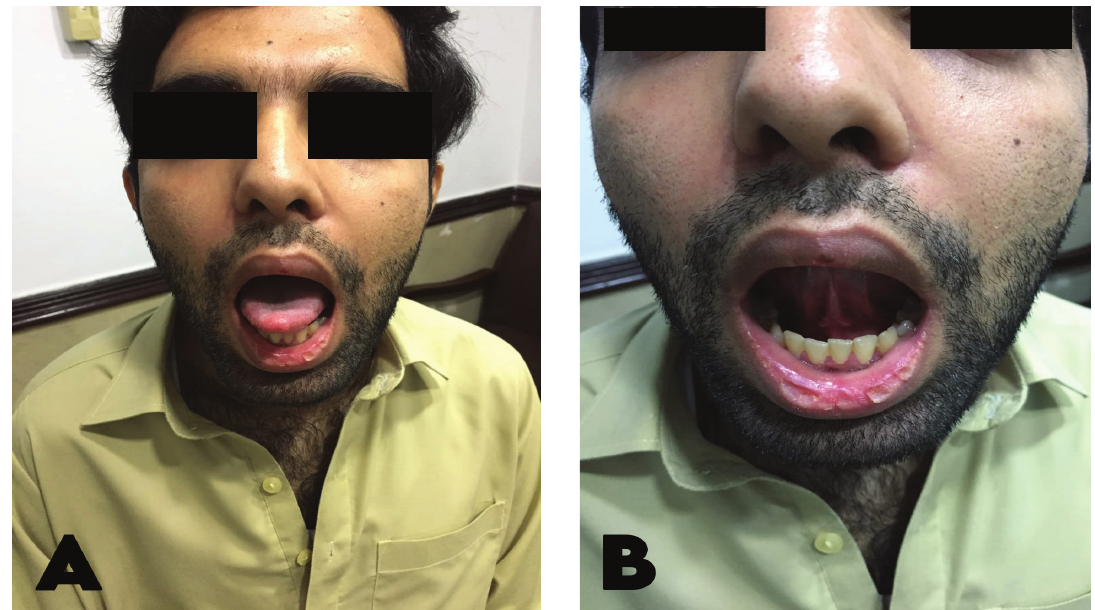
Figure-IV: Post-Operative View (A) Intraoral view with normal protrusion of tongue (B) Floor of the tongue.